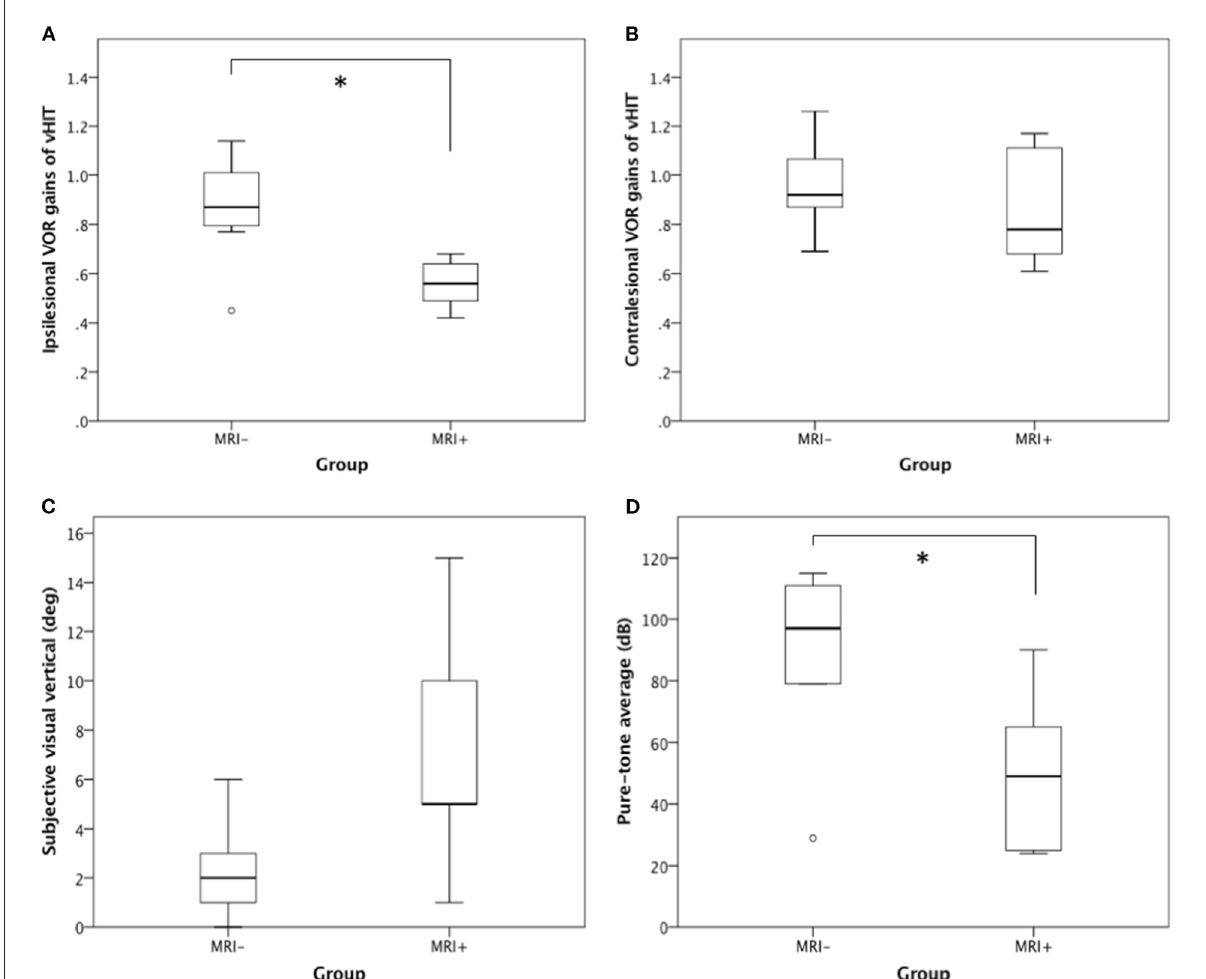
FIGURE2 H-vHIT, SVV, and PTA between MRI + and MRI– group. When compared with the MRI– group, the MRI + group had (A) lower ipsilesional VOR gain in H-vHIT (0.56 ± 0.11 vs. 0.87 ± 0.24, p = 0.03), (B) similar contralesional VOR gain in H-vHIT (0.87 ± 0.25 vs. 0.96 ± 0.19, p = 0.43), (C) suggestion of greater SVV deviation (7.2 ± 5.4 ◦ vs. 2.3 ± 2.0 ◦ , p = 0.11), and (D) lesser degree of hearing loss on PTA (50.6 ± 28.0 dB vs. 89.8 ± 28.5 dB, p = 0.03). *Signifies statistically significant